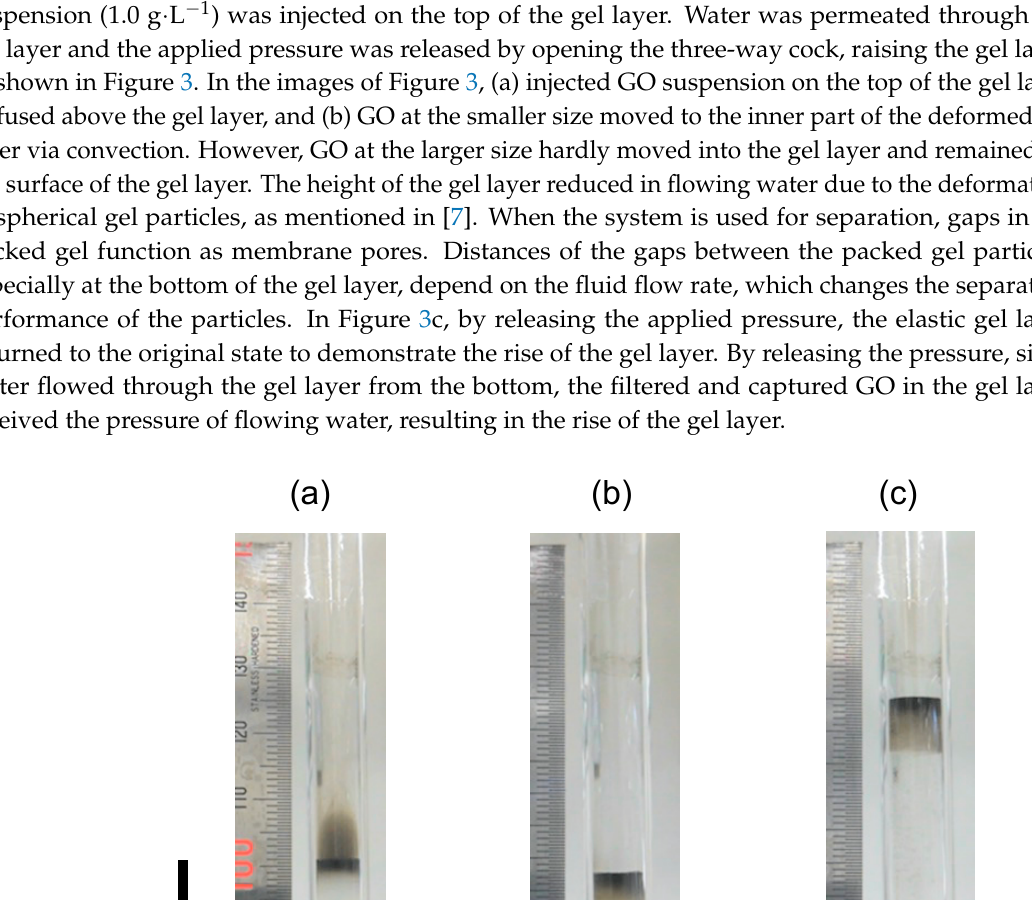
Figure 3. Picture of the rising elastic gel layer in the column. ( a ) Before permeation; ( b ) during permeation; and ( c ) after releasing the applied pressure.